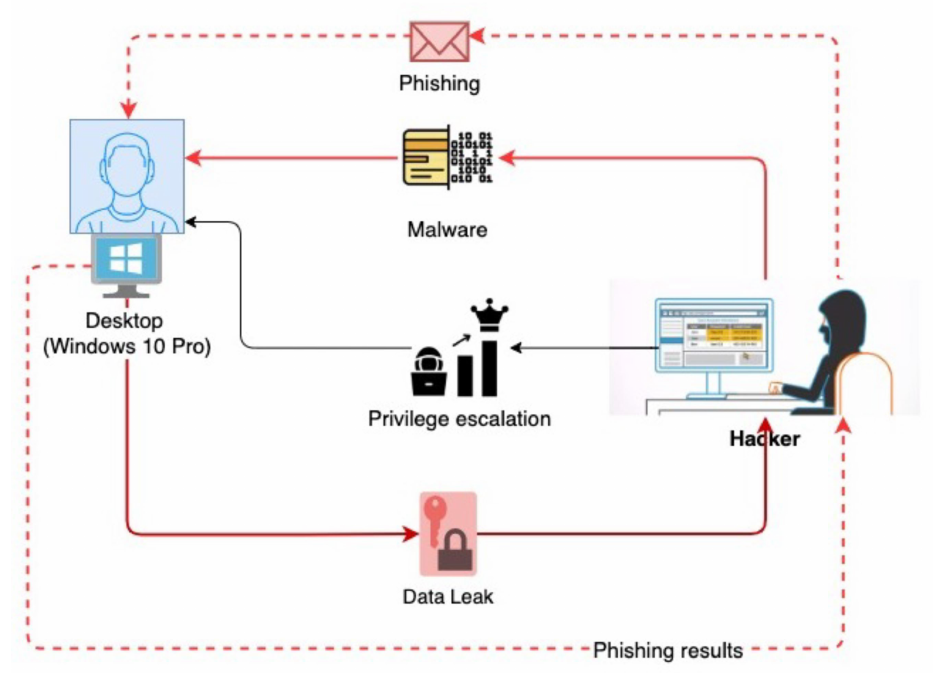
Figure 7. Phishing